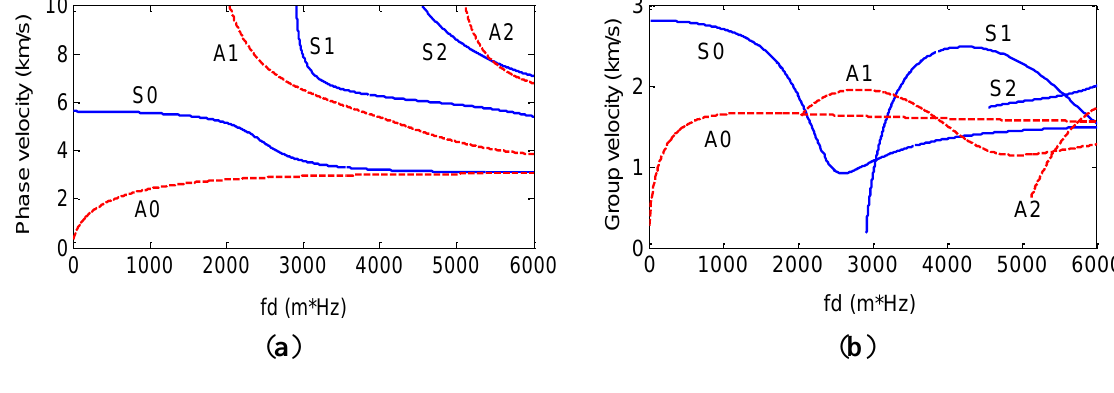
and ( b ) c for the 3 mm thick p g